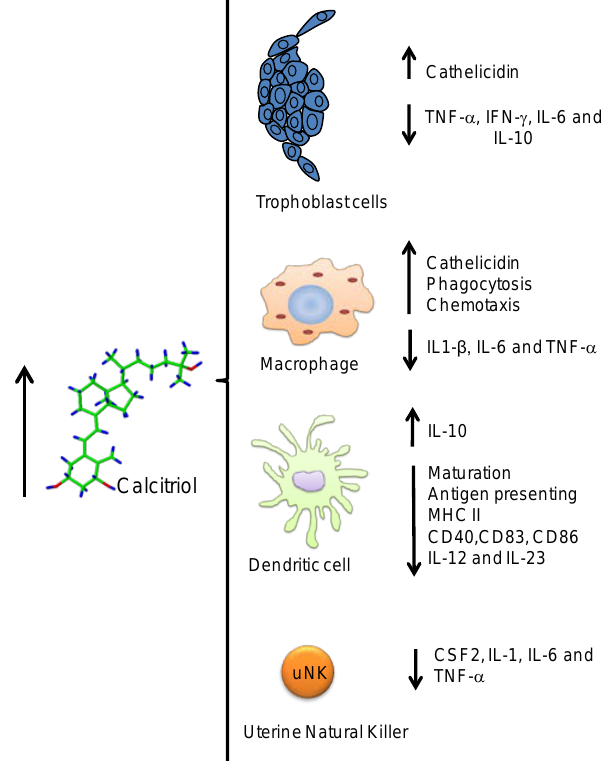
Figure 1. Calcitriol effects upon the immune system during pregnancy. Calcitriol regulates several components of the immune system at the systemic and fetoplacental compartments both in immune cells (macrophage, dendritic, uterine natural killer, and lymphocytic) and non-immune cells (trophoblast) leading changes toward a Th2 profile.